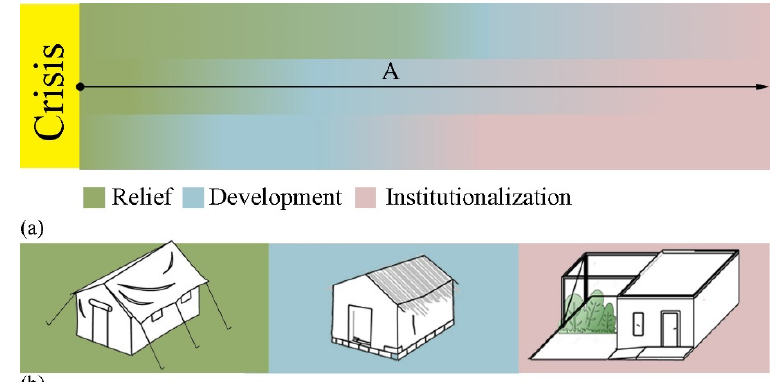
Figure 4. ( a ) Emergency shelter based on crisis ‐ recovery timeframe. Adapted from [26] ( b ) Typical temporary, transitional, and permanent shelters.